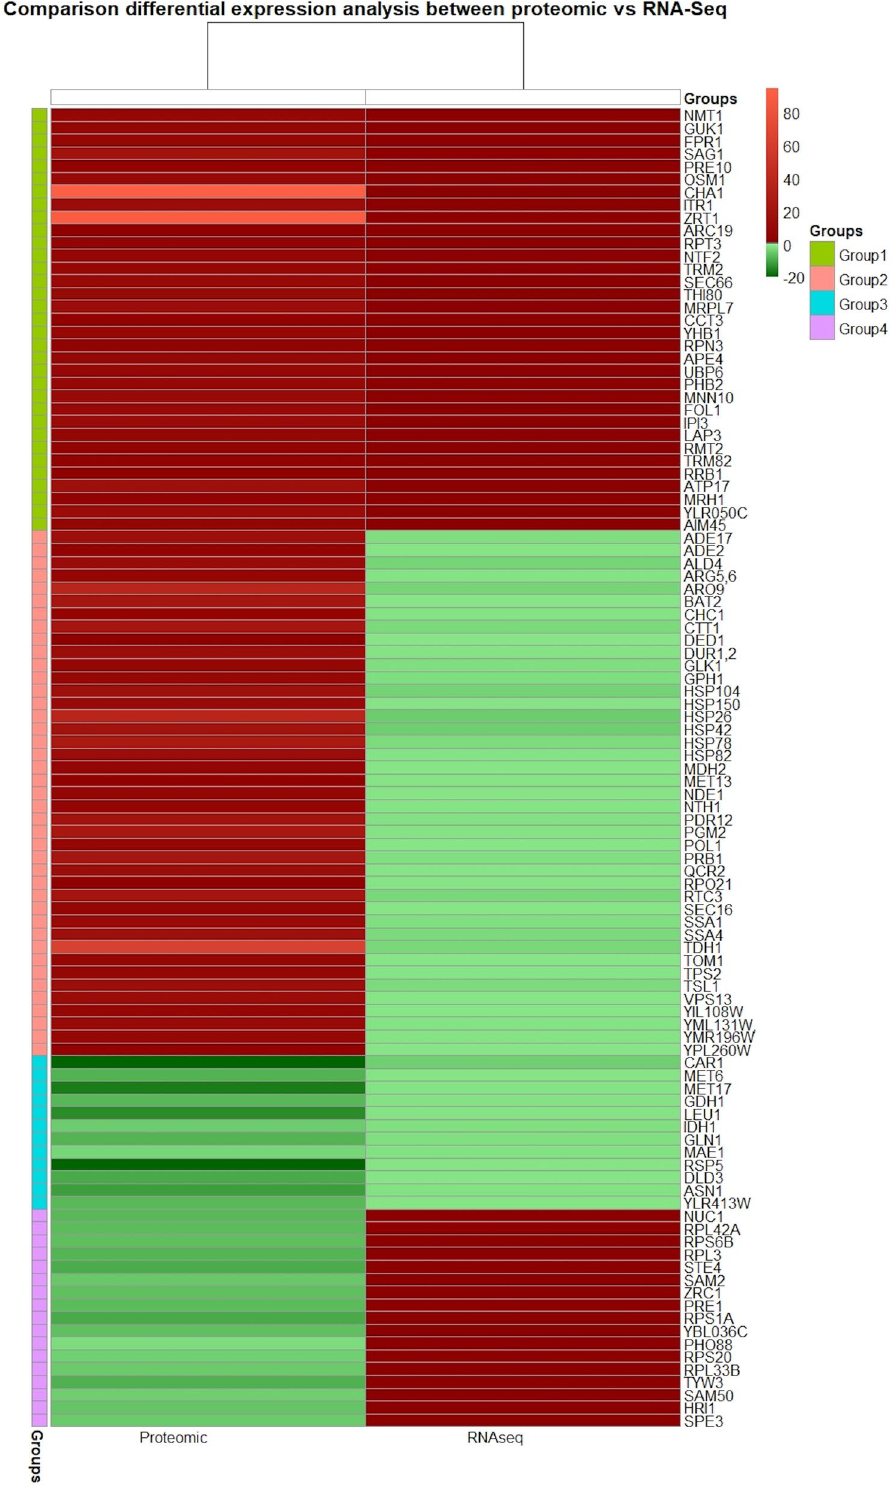
Figure 1. Comparison of differential protein and mRNA expression profiles. (Left panel, Proteomic_FC) 104 proteins identified on the right margin, with statistically significant changes in abundance of twofold or greater in the mtl1Δ strain are shown alongside their mRNAs (Right panel, RNAseq_FC) with expression changes of twofold or greater. Note that a significant block of proteins correlated with their mRNA levels, while others did not correlate (see Results and Discussion for details). The color scale indicates relative fold-change (Red = FC ≥ 2, Green = or FC ≤ − 2), P value ≤